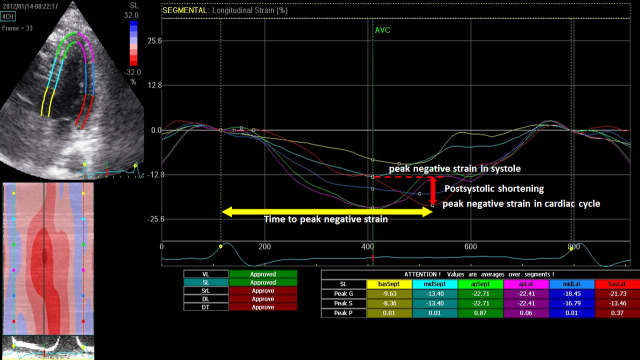
Illustration of Post-systolic shortening (PSS) and time to peak negative strain.Post-systolic shortening was defined as peak negative strain in cardiac cycle—peak negative strain in systole.